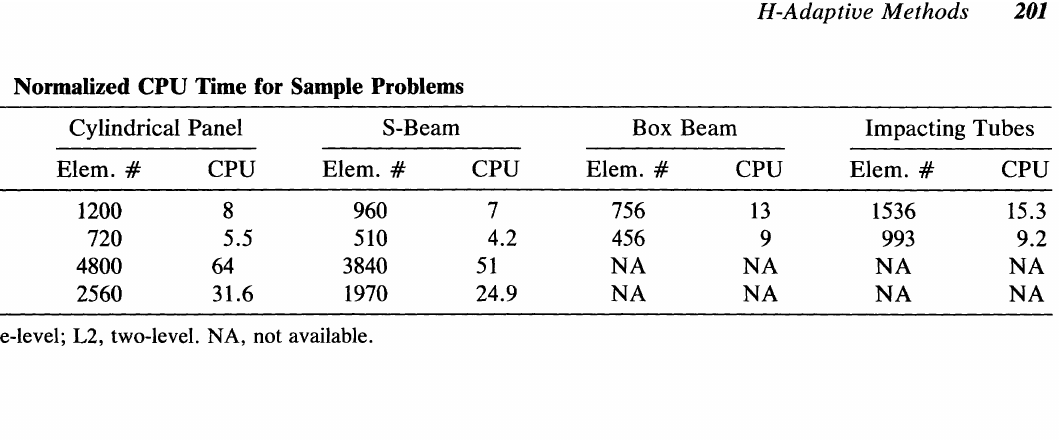
FIGURE 6 Geometry of S-beam.